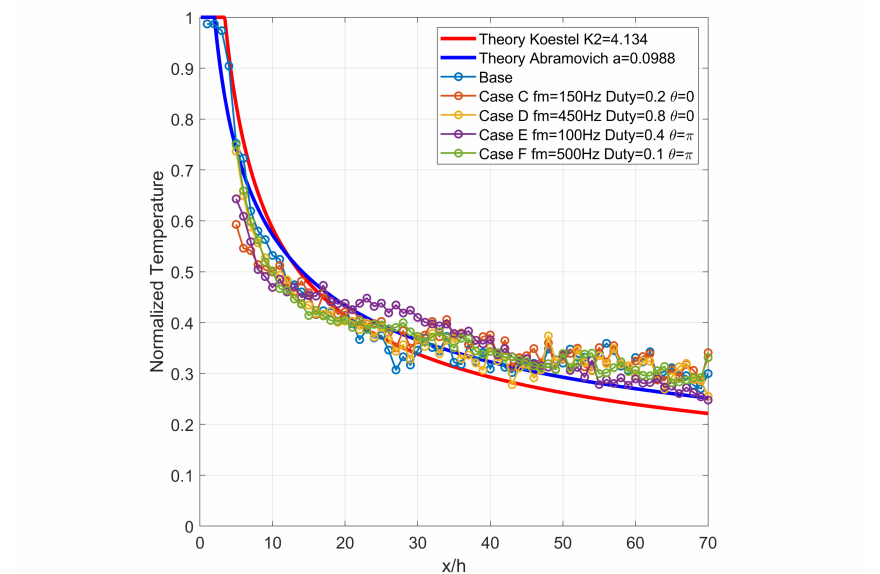
Figure 23. Comparison of centerline temperature between